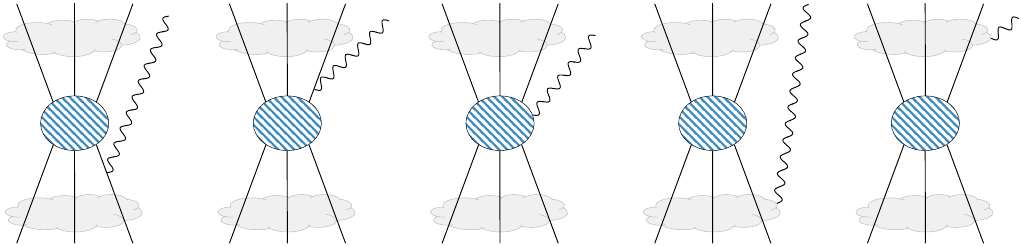
Figure 3. Diagrams contributing to an amplitude with external soft boson. The (cid:12)rst two diagrams cancel the last two diagrams, and only the diagram in the middle remains, which is of zeroth order in the soft